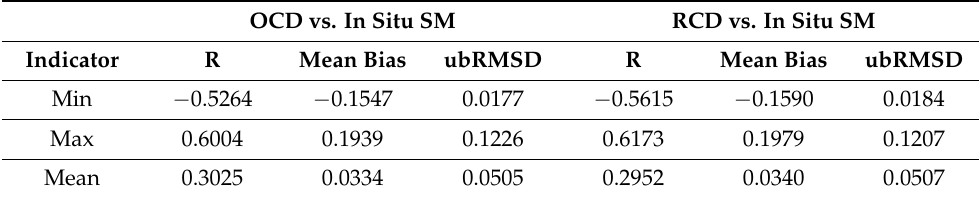
Figure 9. Validation of soil moisture retrieved using OCD ( a , c , e ) and RCD ( b , d , f ) based on autostation observations. Table 2. Summary of the average validation indicators of soil moisture retrieval based on in situ soil